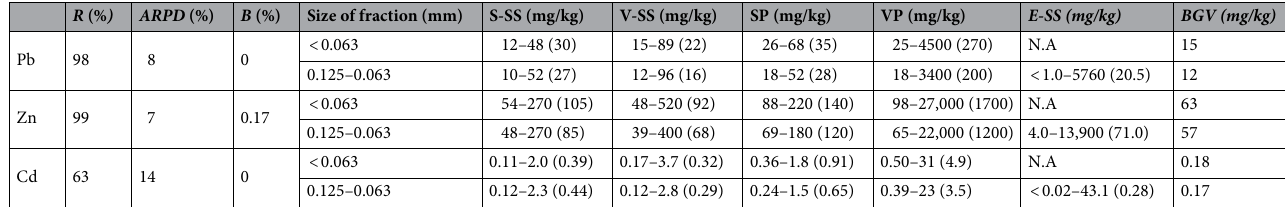
Table 2. Descriptive statistical parameters of Pb, Zn and Cd levels (mg/kg) in stream and alluvial sediments collected in Savinja and Voglajna Rivers in two analysed grain size fractions. The presentation format is: